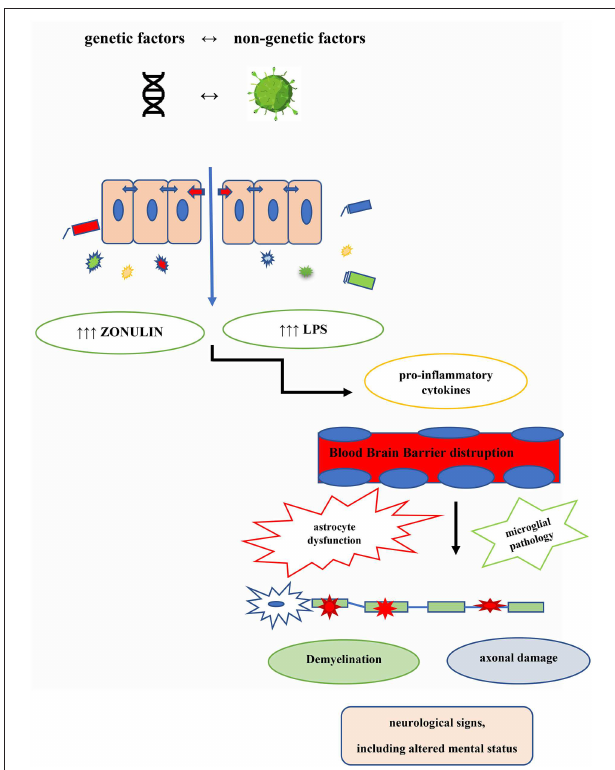
FIGURE 1 | MS pathogenic loop centered on the gut barrier disruption. Genetic and non-genetic aetiologic factors contribute to the co-occurring intestinal permeability changes (IPC) and dysbiosis, that in turn bring about the MS pathogenic cascade.